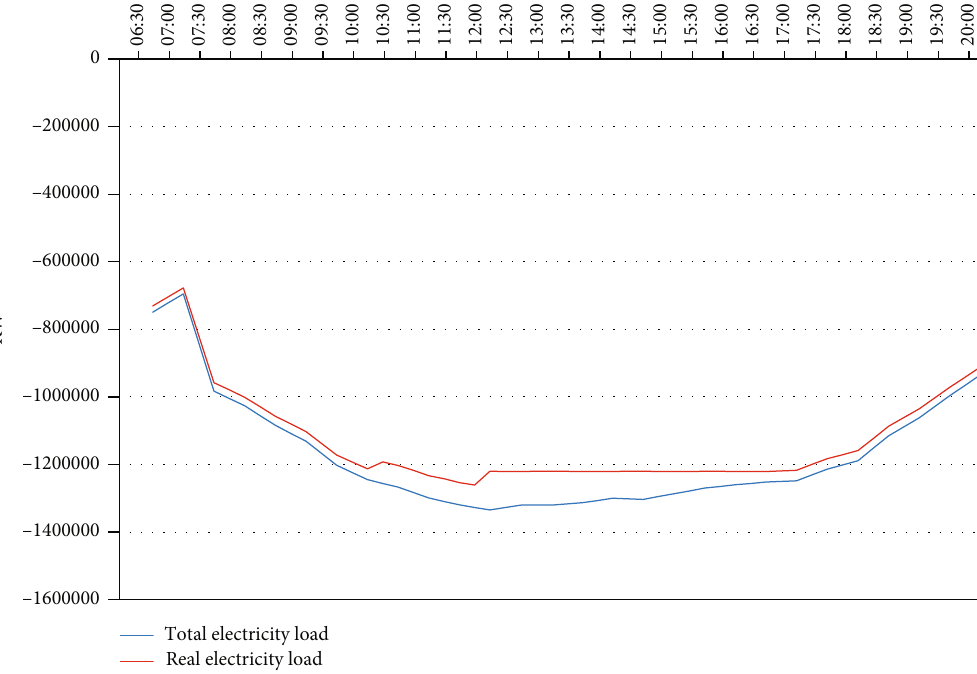
Figure 15: Model validation, comparison of simulated electricity load, and real electricity load in